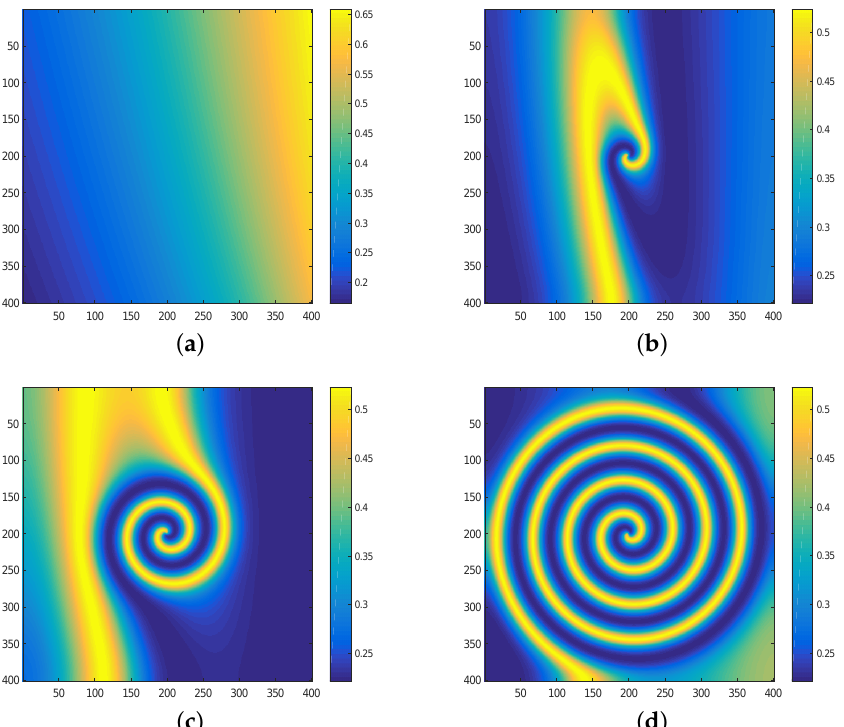
Figure 10. The spiral patterns formation process of the model (3), the parameters are given by (41). Times: ( a ) t = 0, ( b ) t = 1000, ( c ) t = 5000, and ( d ) t =